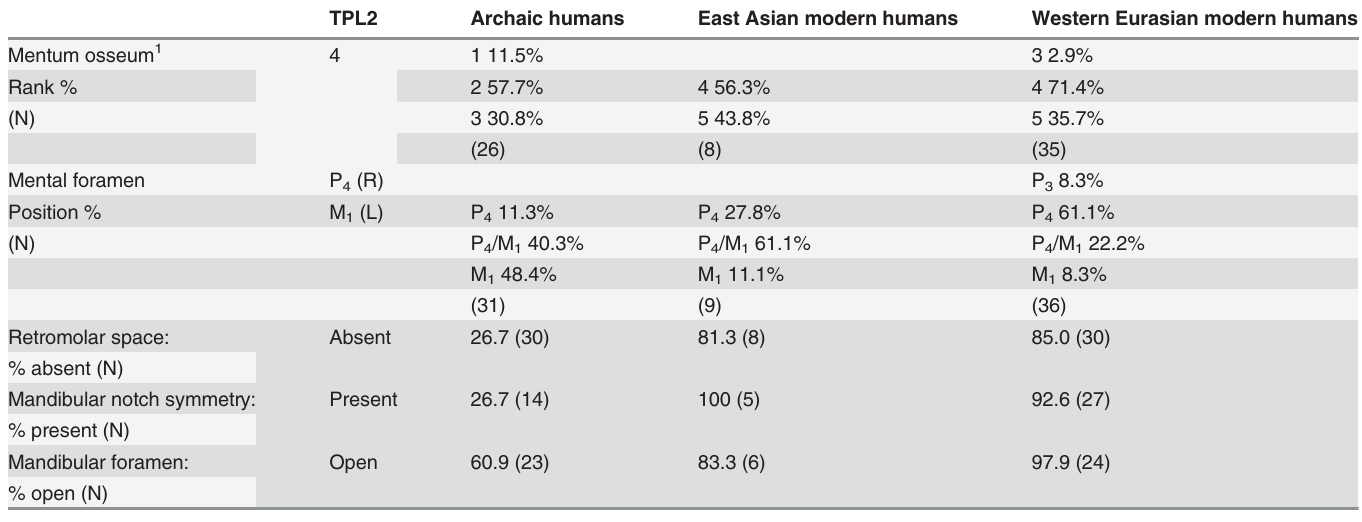
Table 4. Discrete traits of the TPL2 mandible and their frequency in Late Pleistocene comparative samples. See SI for fossils included in analyses. TPL2 Archaic humans East Asian modern humans Western Eurasian modern humans Mentum osseum 1